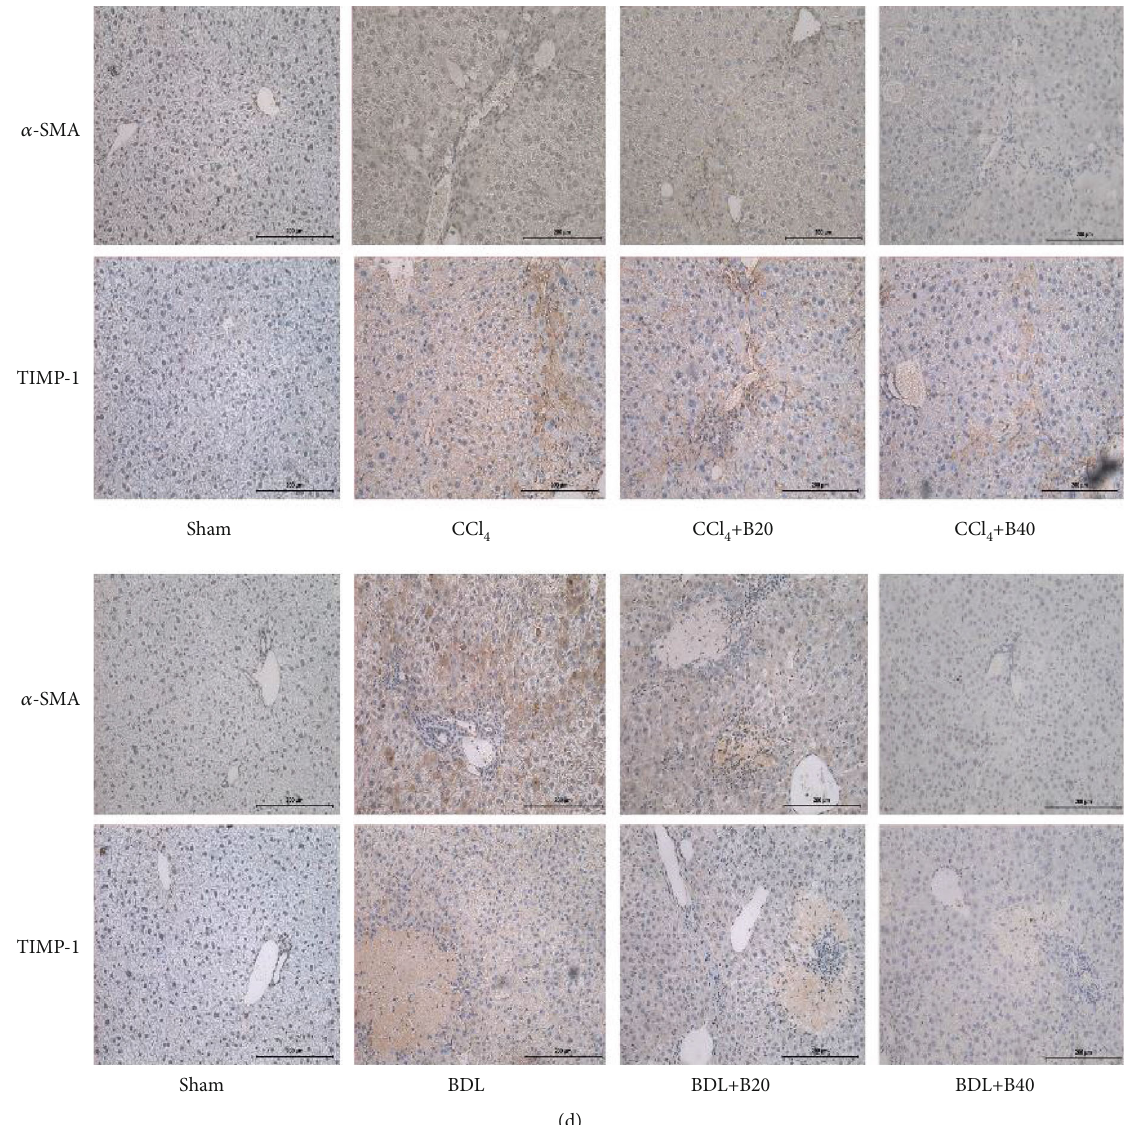
Figure 2: Bergenin inhibits the formation of the extracellular matrix. (a) Levels of serum HA and LN expressed as the mean ± SD ( n = 8 ). (b) mRNA expression of collagen I, α -SMA, and TIMP1 assessed by real-time PCR ( n = 8 ). (c) Protein expression of collagen I, α -SMA, and TIMP1 assessed by western blotting. The quantitative evaluation was determined by relative band density. (d) Immunohistochemical staining of α -SMA and TIMP1 (original magnification = 200x ). ∗ p < 0 : 05 for CCl /BDL vs. sham, # p < 0 : 05 for CCl /BDL+B20 vs. 4 4 CCl /BDL, and ^ p < 0 : 05 for CCl /BDL+B40 vs. CCl 4 4 4